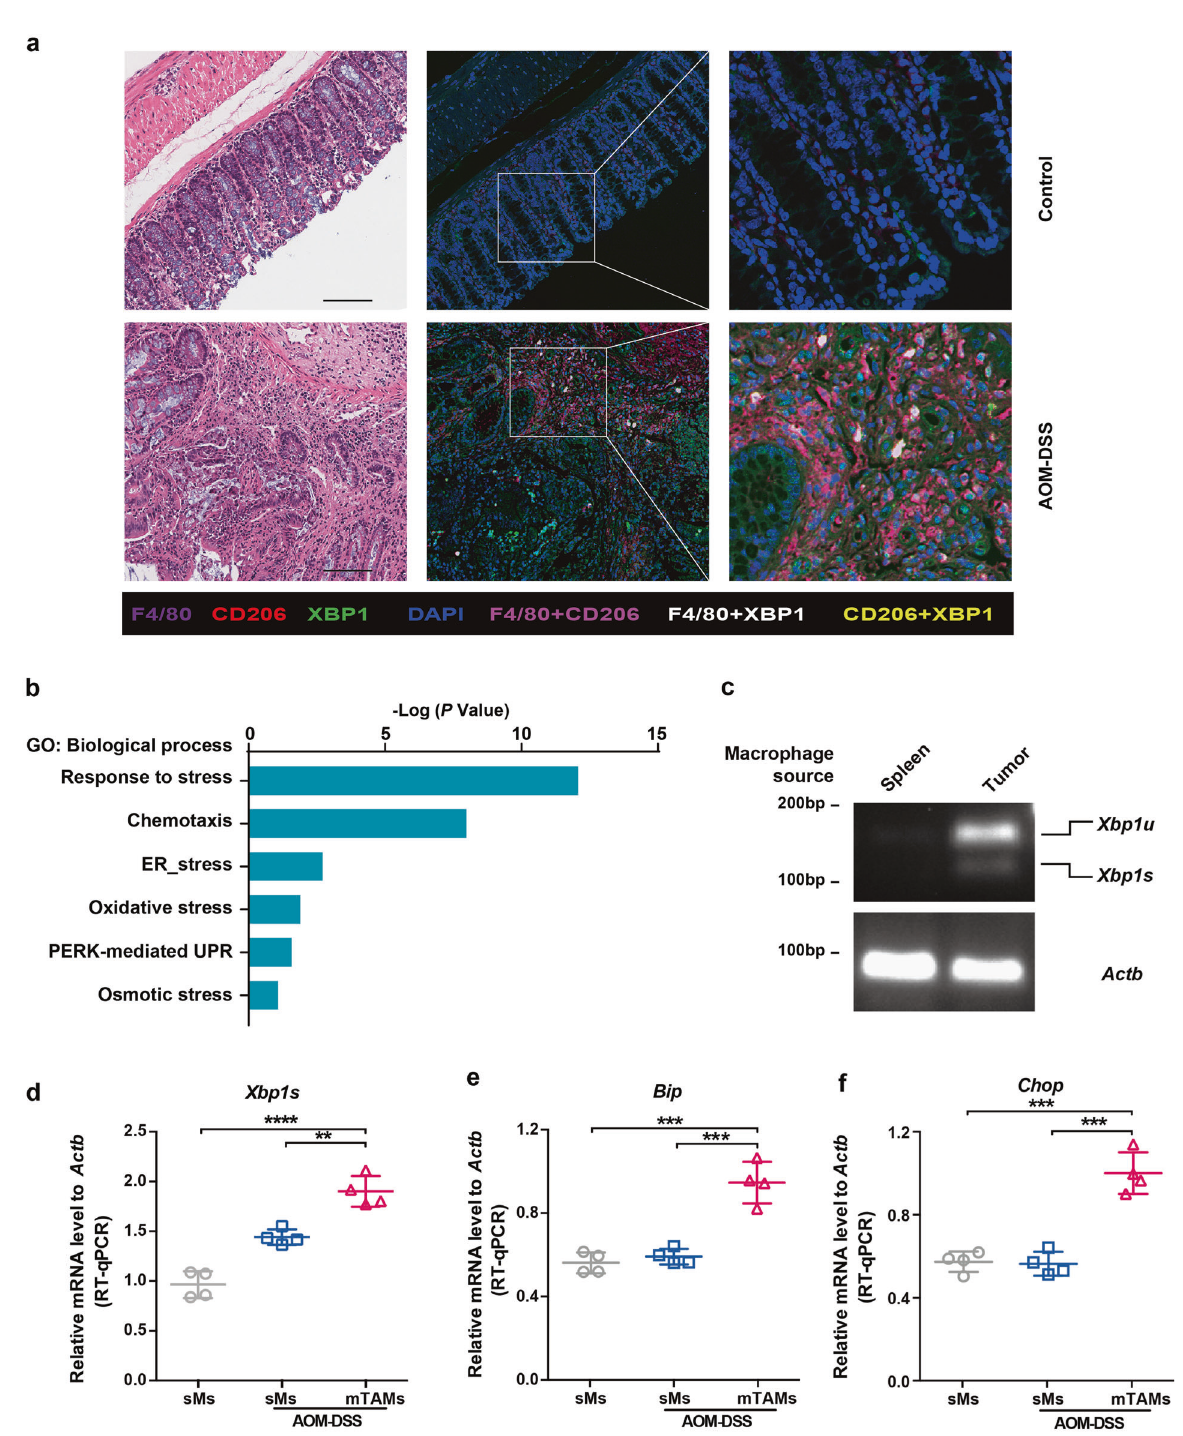
Fig. 2 XBP1 activation in AOM-DSS-induced colorectal cancer-associated macrophages. a F4/80, CD206, and XBP1 immuno fl uorescence in colon sections from healthy and AOM-DSS mice. Scale bar: 100 μ m. b Gene Ontology (GO) term analysis of differentially regulated genes, as revealed using RNA-seq, in four paired mTAMs and spleen macrophages (sMs). c Xbp1 splicing was evaluated using conventional RT-PCR and agarose gel electrophoresis. d Expression of XBP1s in spleen macrophages (sMs) and mTAMs evaluated via RT-qPCR. Data were normalized to endogenous levels of ACTB . e , f Expression of the UPR/ER stress response transcripts Bip and Chop determined by RT-qPCR. Data normalized to endogenous levels of ACTB . ( n = 4 mice per group); ** P < 0.01, *** P < 0.001, **** P < 0.0001; ANOVA test